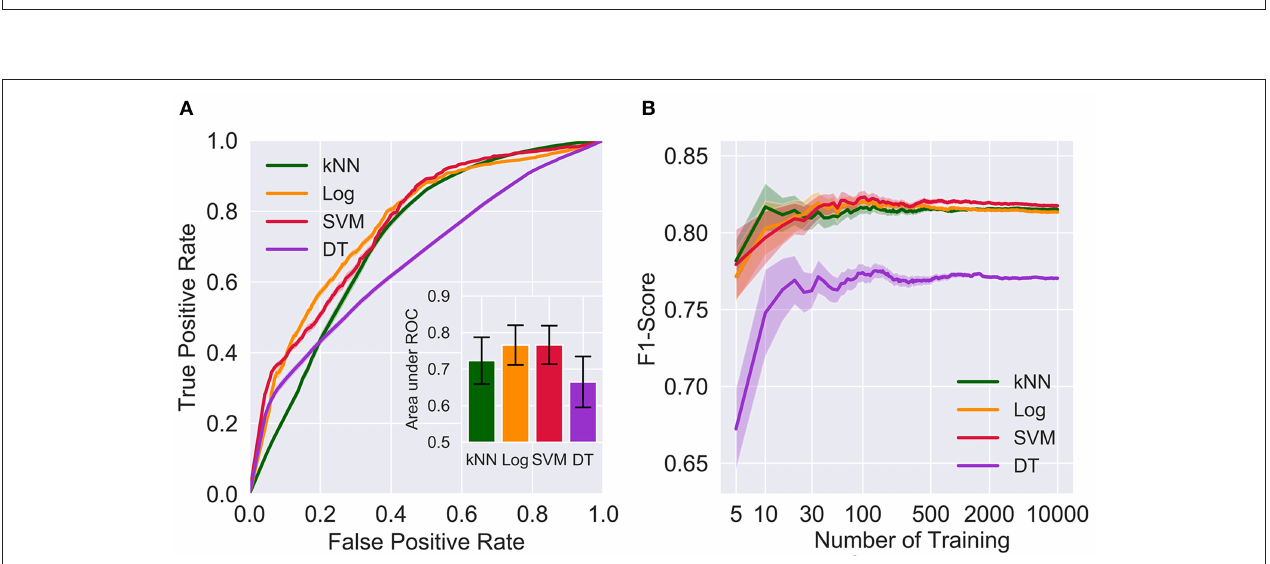
FIGURE 2 | Comparison on the areas under the ROC of the kNN (0.723 ± 0.064), Log (0.766 ± 0.054), SVM (0.766 ± 0.053) and DT (0.665 ± 0.070) and the effects of the number of trainings on F1-scores. The error bars in (A) represent one standard deviation of uncertainty. The shaded regions in (A,B) represent one standard error of the mean. kNN, k-nearest neighbors; Log, logistic regression; SVM, support vector machine; DT, decision tree; ROC, receiver operating characteristic